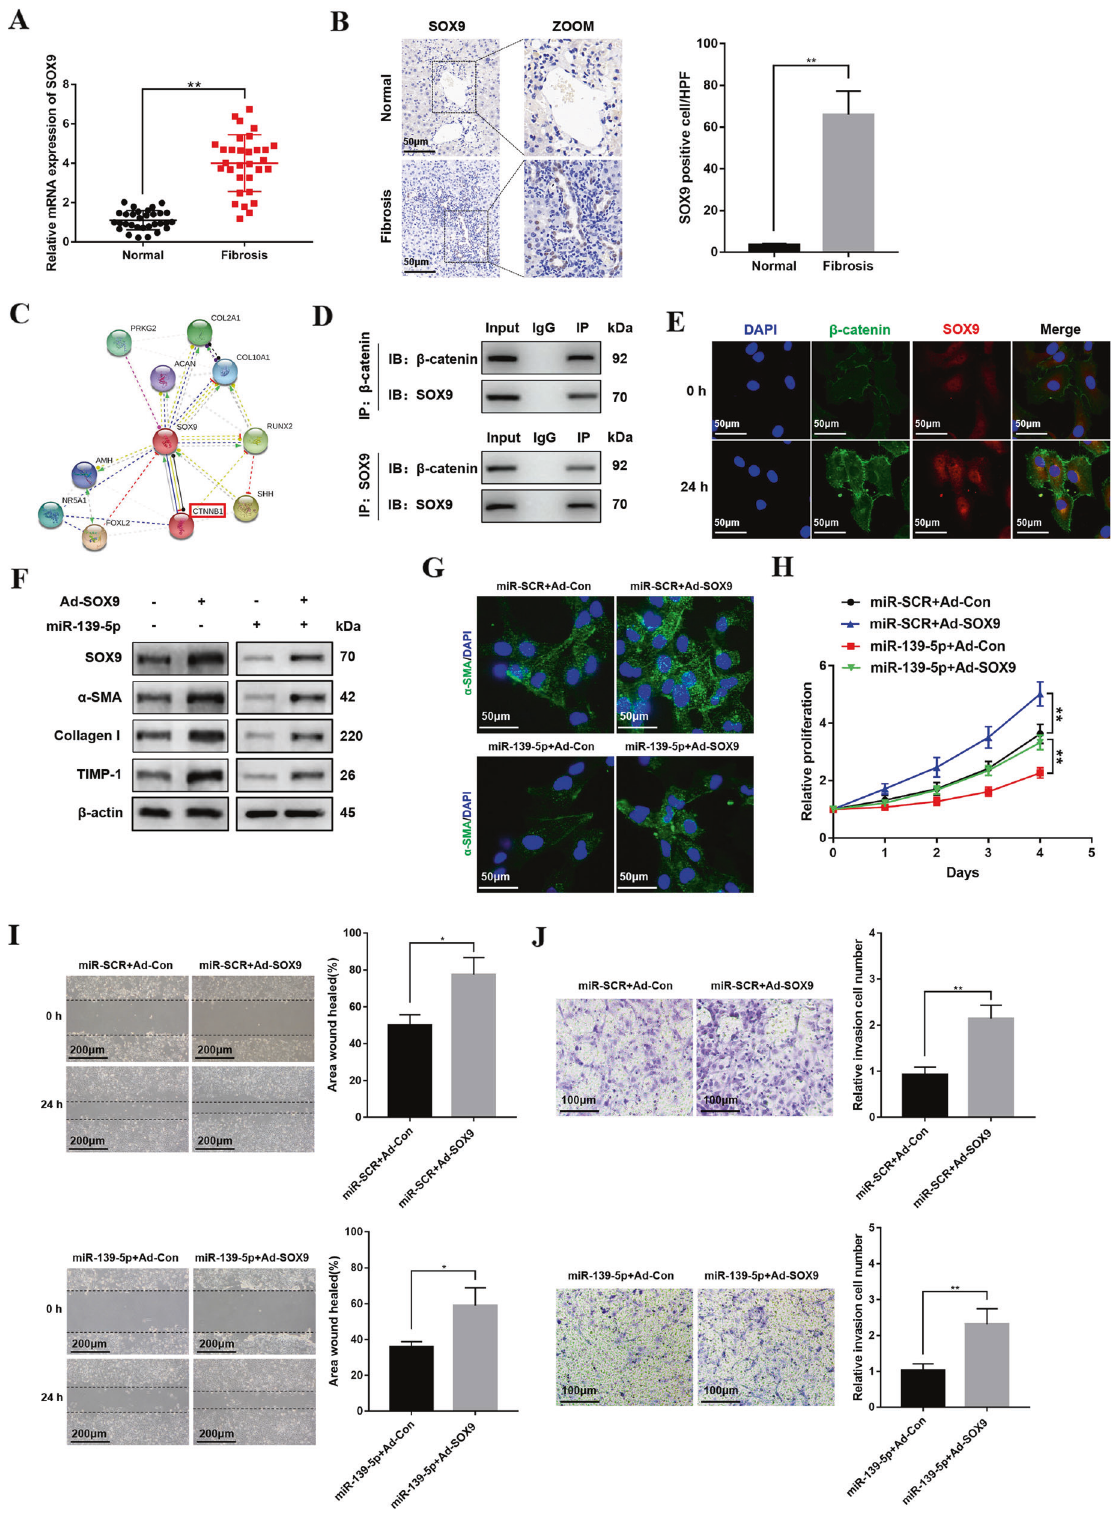
in HSCs activation, TGF- β 1 adenovirus was used to overexpress TGF- β 1 in LX-2 cells transfected with miR-139-5p mimics. The overexpression of TGF- β 1 could promote the expression of pro fi brotic markers including α -SMA, Collagen-I, and TIMP-1 in LX-2 cells transfected with miR-139-5p mimics (Fig. 6F),